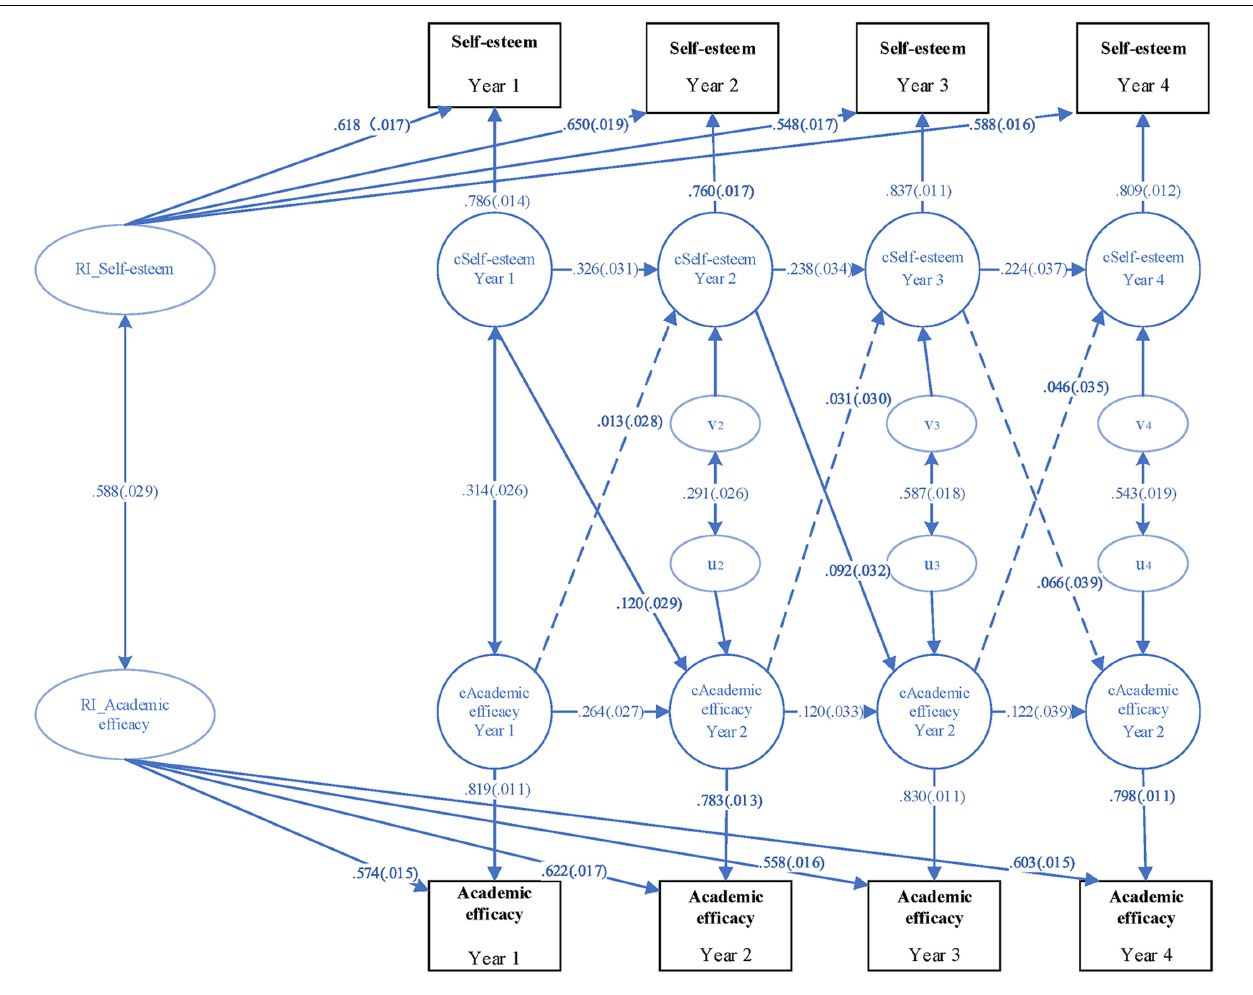
FIGURE 1 | A four-wave cross-lagged panel model with random intercepts (all